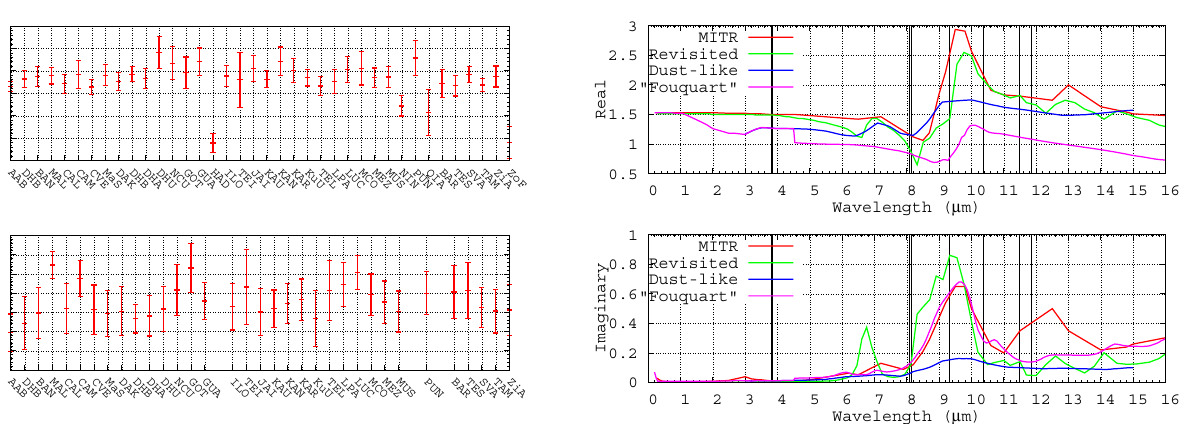
Figure A2. Real (top) and imaginary (bottom) refractive index for the MITR model (Hess et al., 1998; Volz, 1973) in red; the “revis- ited” (Balkanski et al., 2007) model in green; the “dust-like” model from Volz (1972, 1973) in blue, and “Fouquart” et al. (1987) in pink. Black vertical bars indicate the location of the IASI channels used in the aerosol